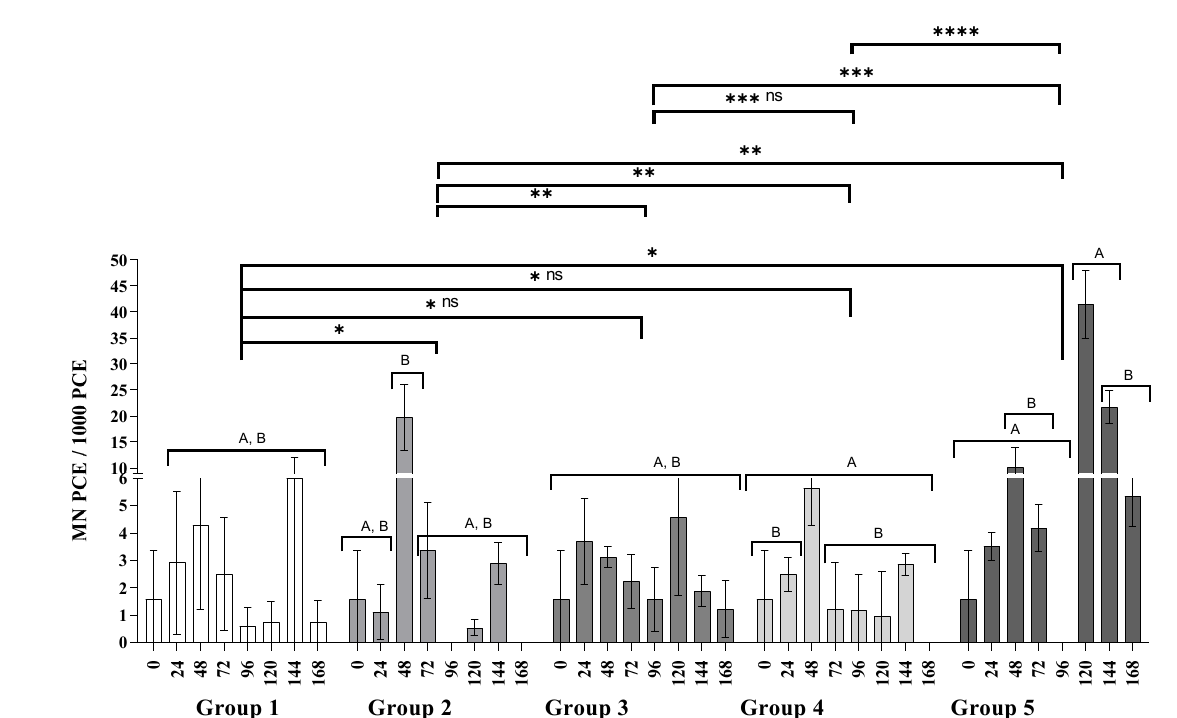
Figure 4. Micronucleated polychromatic erythrocytes observed in 1000 polychromatic erythrocytes. Group 1: water (0, 24, 48 h), Group 2: CP (0 h), Group 3: AgNPs (0, 24, 48 h), Group 4: CP + AgNPs; CP (0 h) + AgNPs (24, 48, 72 h), and Group 5: CP +AgNPs; CP (0, 48, 96 h) + AgNPs (24, 72, 120 h). ns: no significant difference; *, **, ***, and **** denote statistically significant differences between groups ( p < 0.0001); letters A and B denote statistically significant differences between inter and intragroup concentrations ( p < 0.0001). Numeric data used to build the graph can be consulted in Table S2.